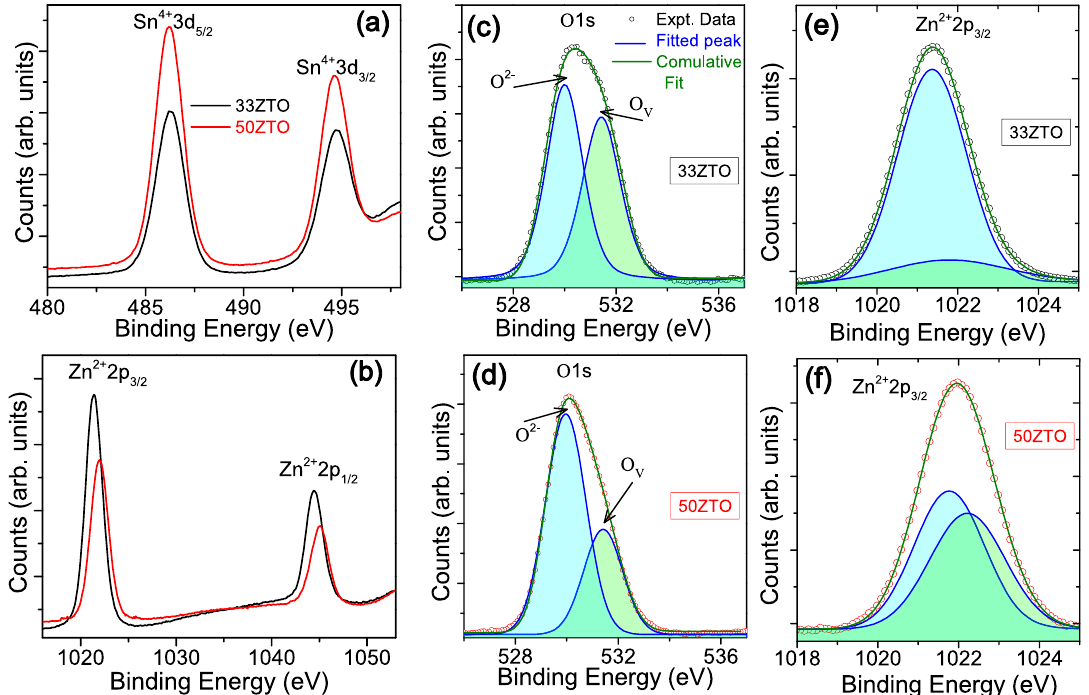
Figure 5. XPS binding energy spectra of the ZTO thinfilms with an elemental composition identical to semiconductor channel of 33ZTO and 50ZTO TFTs for the core level of: ( a ) Sn3d, ( b ) Zn2p, ( c and d ) O1s and ( e and f ) Zn 2+ 2p 3/2 . Individual component (lattice oxygen and oxygen vacancy) in the broad and asymmetric O1s spectrum and individual component (lattice Zn in the oxide form and Zn interstitials) in the Zn 2+ 2p 3/2 spectrum are identified after fitting with multiple Gaussian peaks. Solid green line represents the combined fitting of the sum of all the individual components (blue